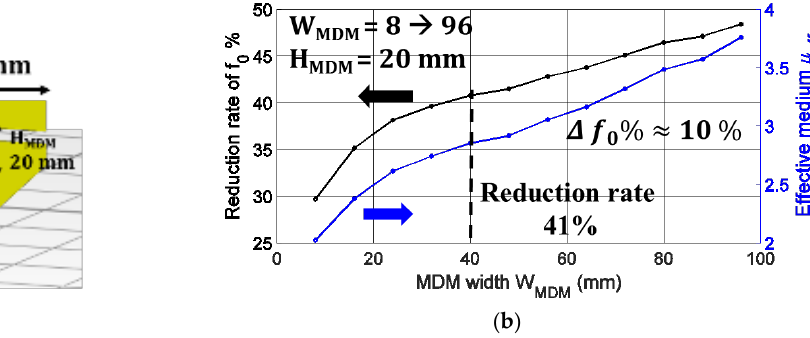
Figure 8. ( a ) Monopole antenna of the height 200 mm with two slots of the width 50 mm. ( b ) Reduc- tion rate of f 0 and μ eff in function of P-MDM width W MDM with a constant H MDM = 20 mm.